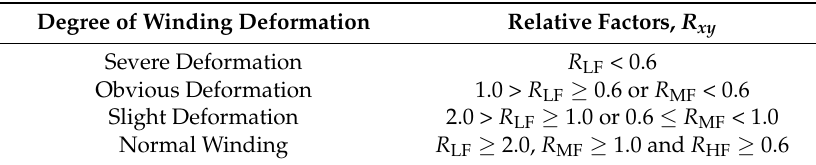
Table 1. The relationship between the winding deformation degree and relative factor. Degree of Winding Deformation Relative Factors, R